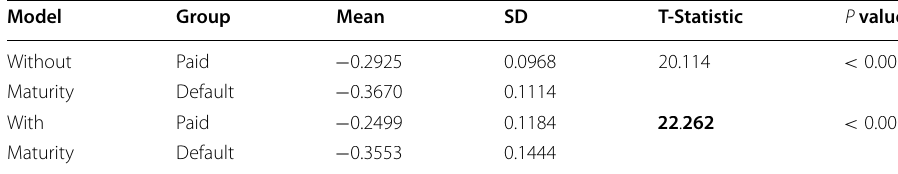
The statistic is considered significant when its P -value is less than 0.05